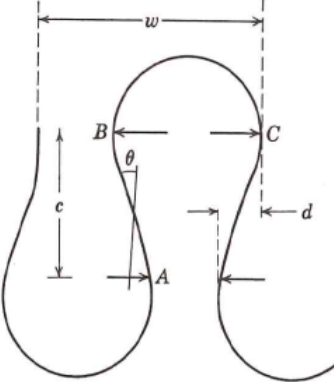
Figure 8. Loop model according to Munden [41].